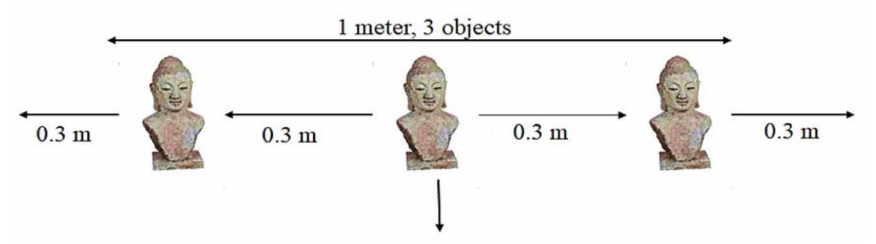
Figure 18. Three objects are placed within one meter.